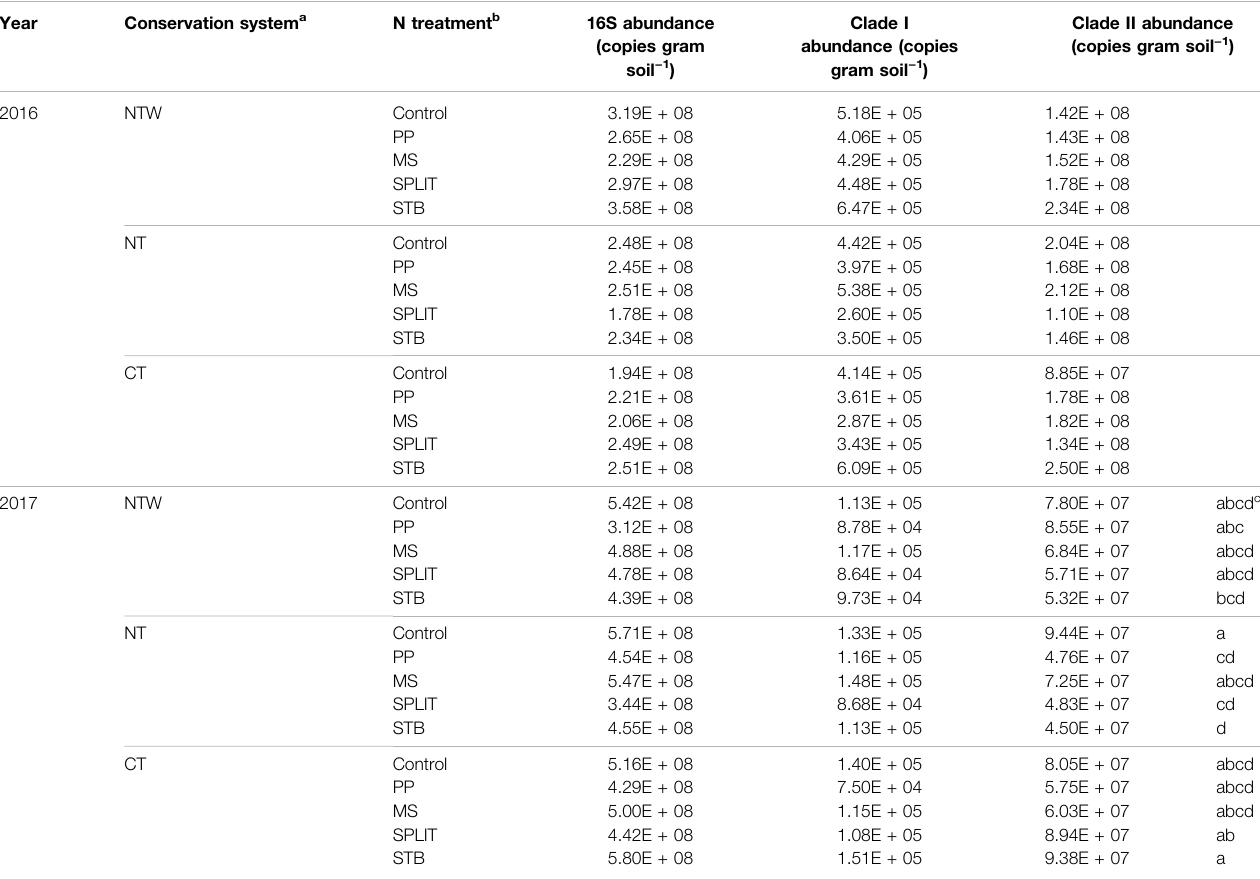
TABLE 3 | Total bacteria, nosZ clade I, and nosZ clade II abundance in 2016 and